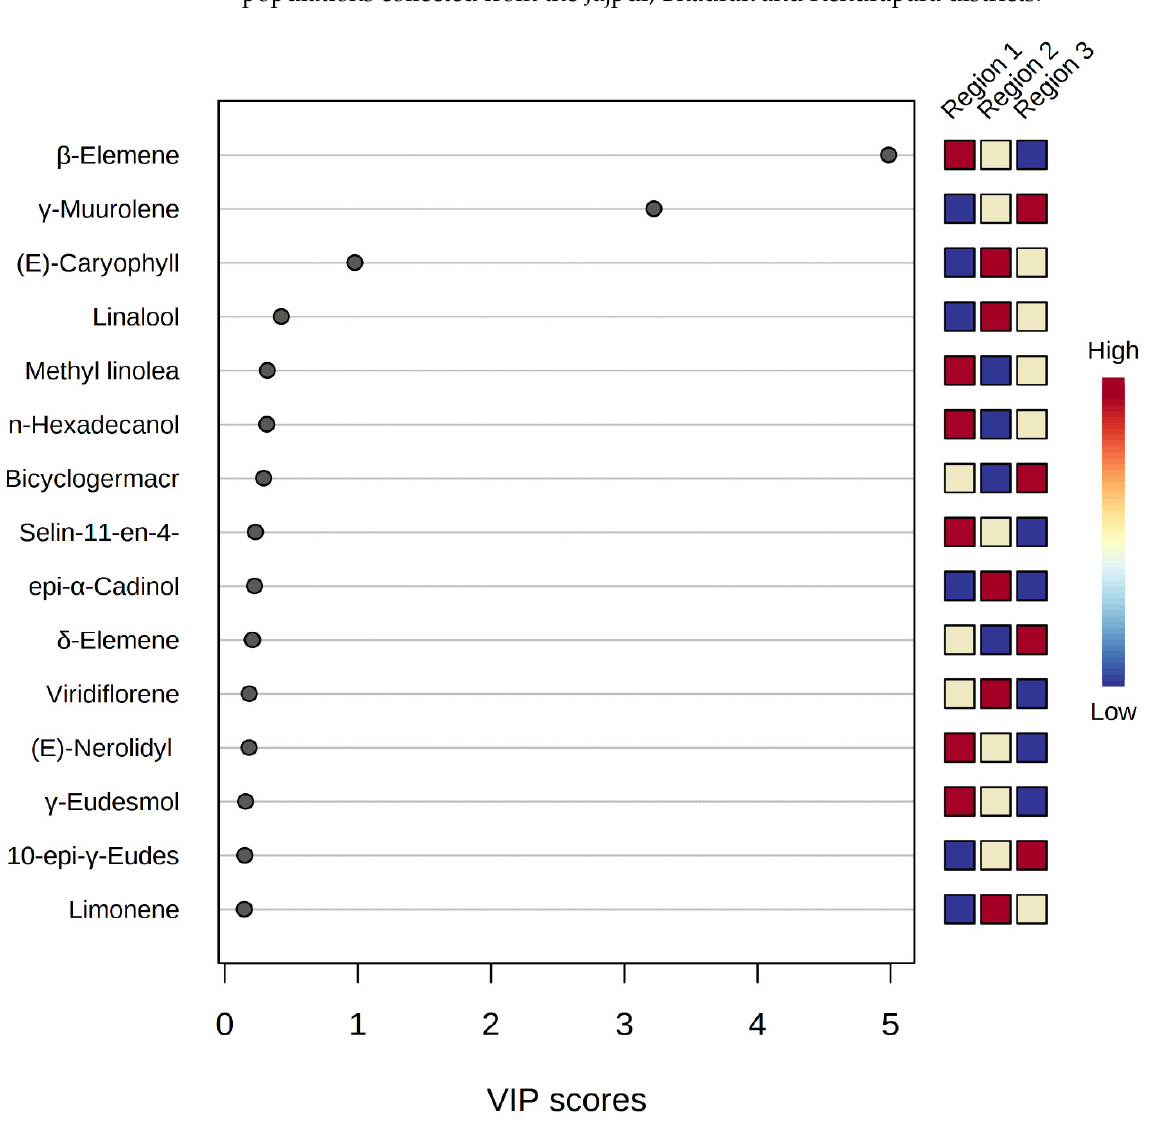
Figure 7. PCA biplot between the selected PCs (PC1 vs. PC2) showing the involvement of major essential oil components (>1%) in the grouping of M. champaca accessions. M. champaca accessions are indicated by names according to Table 1.